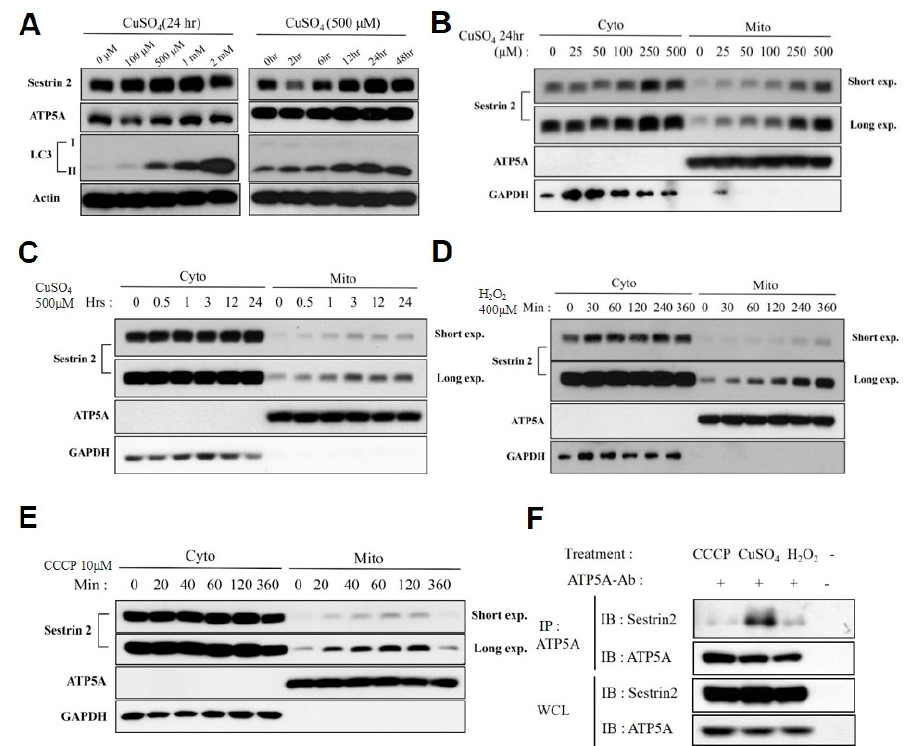
Figure 2. Autolysosome (LC3-II) is accumulated and endogenous Sestrin2 is robustly associated with mitochondria upon chronic treatment with copper. ( A ) Sestrin2, ATP5A, and autophagosome markers LC3-I and II were measured by immunoblotting upon copper (Cu) treatment in indicated concentration and time, as indicated in HEK293 cells. Sestrin2 was induced and associating with mitochondria in ( B ) a dose-dependent manner and ( C ) in a time-dependent manner upon CuSO 4 treatment. Sestrin2 was induced and associating with mitochondria by ( D ) oxidative stress reagent H 2 O 2 and by ( E ) mitochondrial membrane un-coupler CCCP treatment in a time-dependent manner. ( F ) HEK293 cells were treated with 10 µ m CCCP for 2 h, 500 µ m CuSO 4 for 6 h, or 400 µ m H 2 O 2 for 6 h to maximize endogenous Sestrin2 expression. Then, endogenous ATP5A was immunoprecipitated using protein G / A-conjugated anti-ATP5A antibody. Empty protein G / A beads ( − ) with no treatment condition were used as negative control. Both anti-ATP5A immunocomplex (IP) and whole cell lysates (WCL) were assayed through immunoblotting